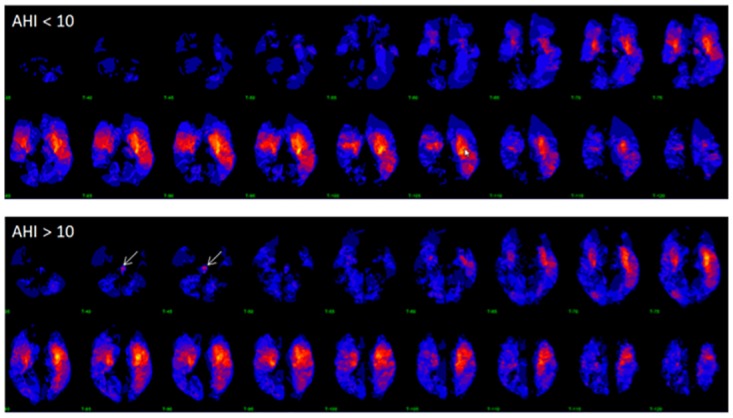
The distribution of infarctions for patients with (AHI > 10) and without (AHI < 10) SRBD.Blue shades: less frequent infarcted regions; Red shades: more frequent infarcted regions. Brainstem infarcts appear to be more frequent in patients with SRBD (arrow, not significant).